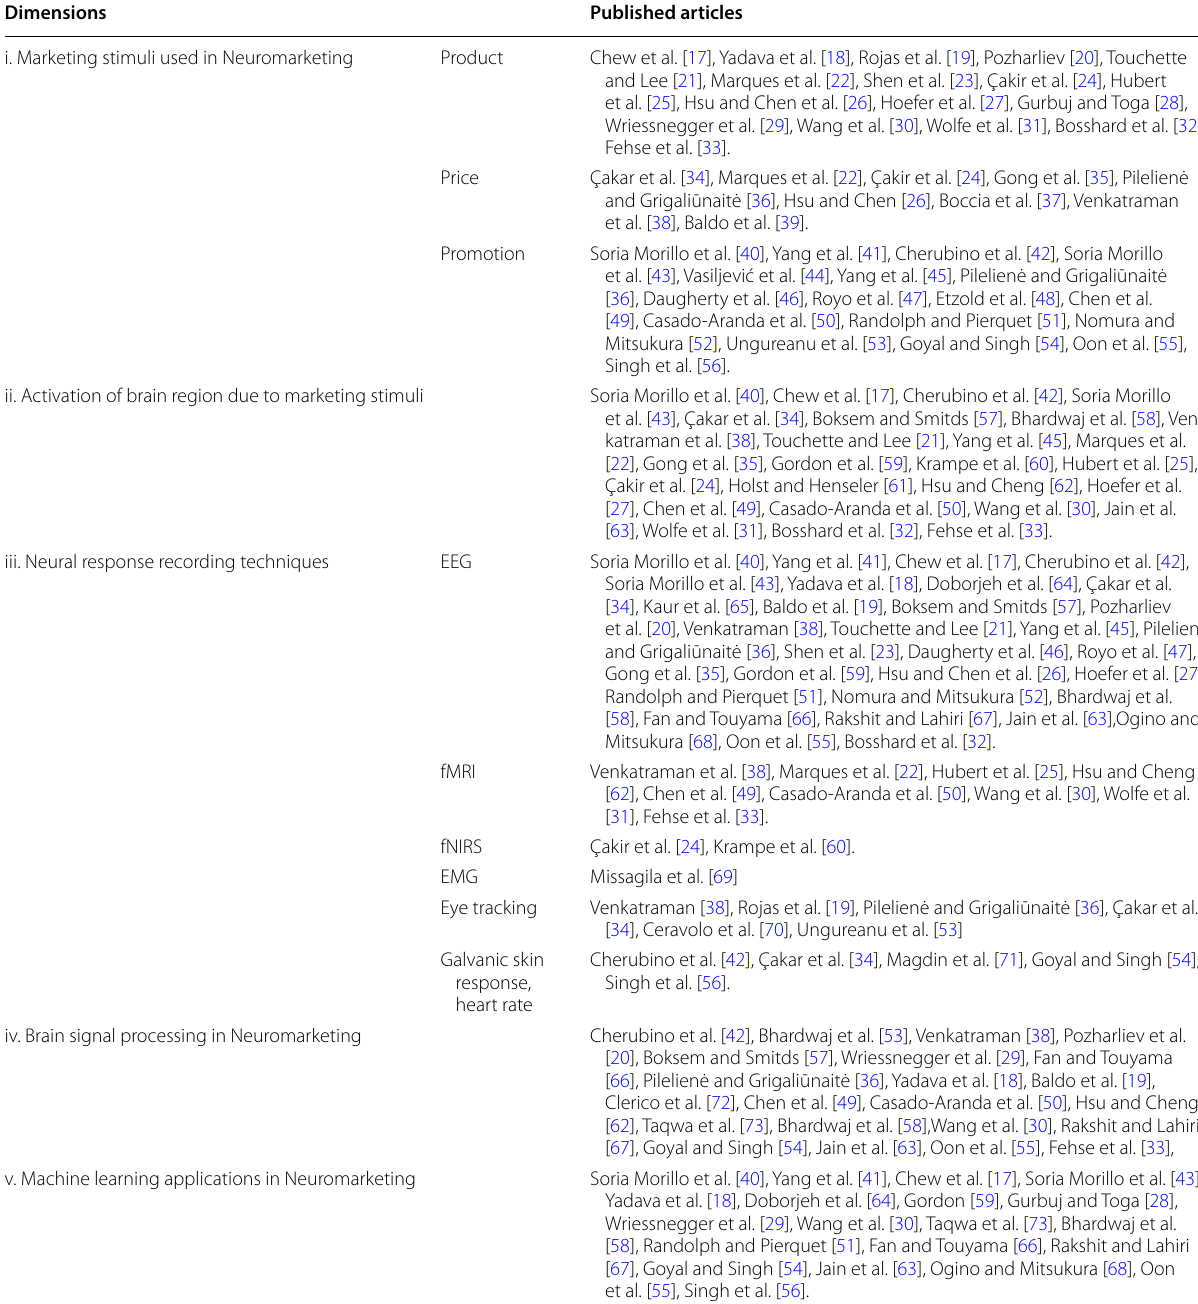
Table 2 Studies selected on the dimensions of this review